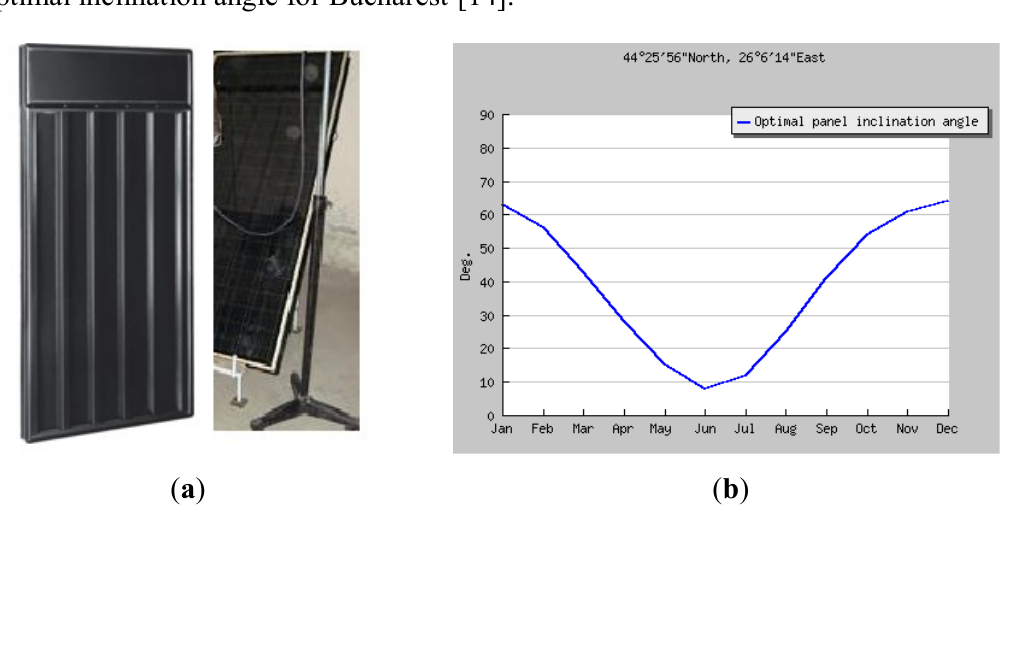
and I ’ are interpolated values with sixth degree a g